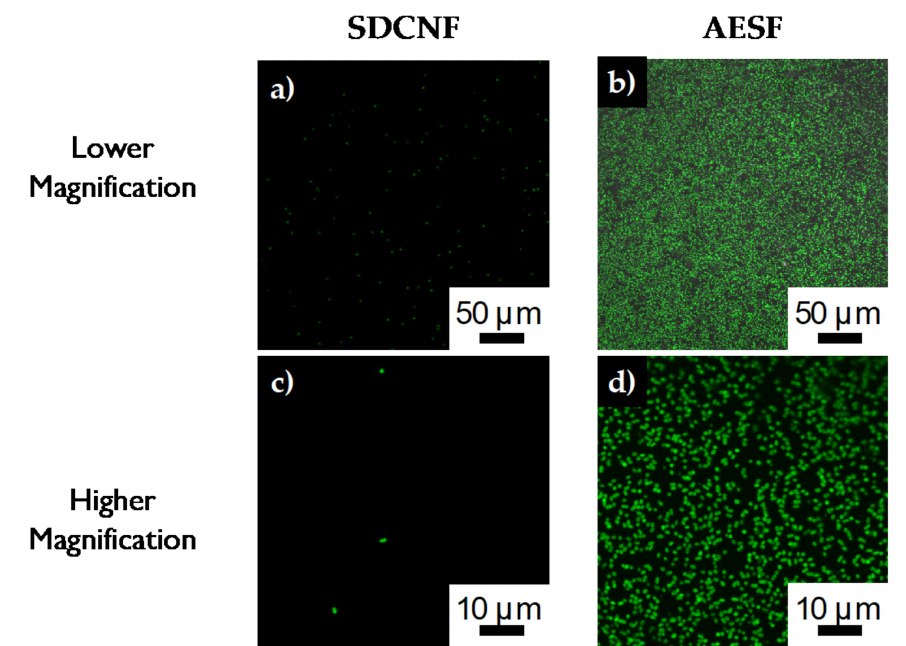
Figure 9. Confocal images of E. coli capture on a , c ) SDCNF mats and b , d ) AESF mats at 3 × 10 7 inlet solution